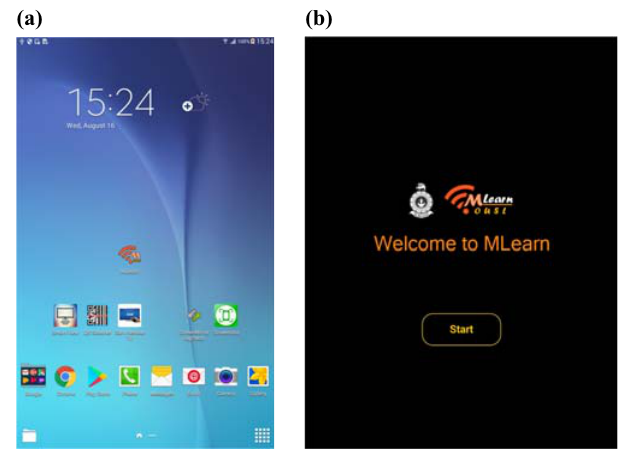
Figure 2. Screen casts of the